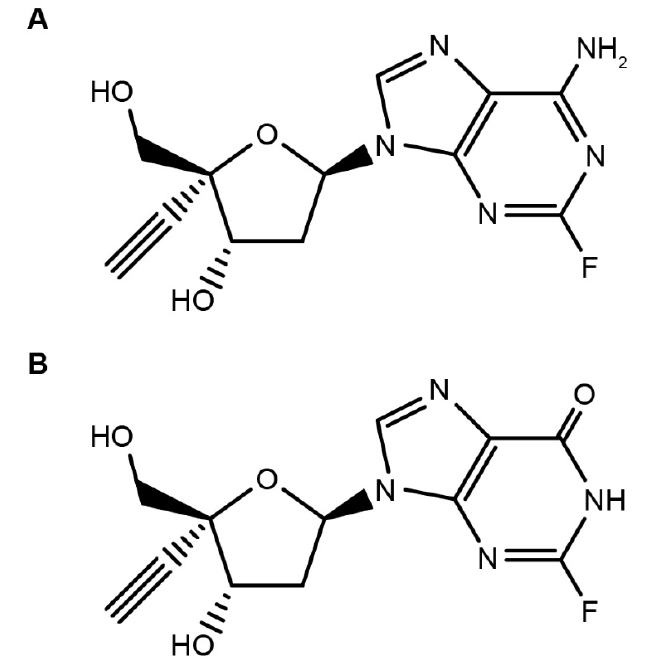
Figure 1. Structure of ( A ) islatravir and ( B ) metabolite M4 4 ′ -ethynyl-2-fluoro-2 ′ -deoxyinosine. Islatravir has a favorable pharmacokinetic profile and is rapidly converted intracellu- larly by endogenous kinases to its active triphosphate (TP), islatravir-TP, which inhibits RT by multiple mechanisms to suppress HIV-1 replication [18,20,21,23–25]. In treatment-naive PLWH, islatravir was rapidly absorbed and plasma exposure was approximately dose proportional after oral administration with similar pharmacokinetics (PK) in adults without HIV. Islatravir-TP had a long intracellular half-life of ~78.5–128 h, in agreement with the viral load reduction maintained for 7 days after a single administration of islatravir at a dose as low as 0.5 mg